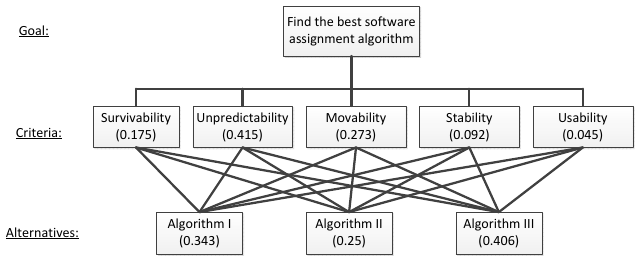
Figure 10. Evaluation